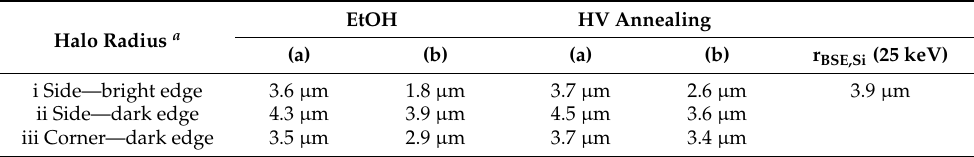
Table 1. Halo radii as measured from squares 8_4 in Figures 2 and 3. The value r BSE,Si (25 keV), denotes the maximum exit range of backscattered electrons on a thick Si